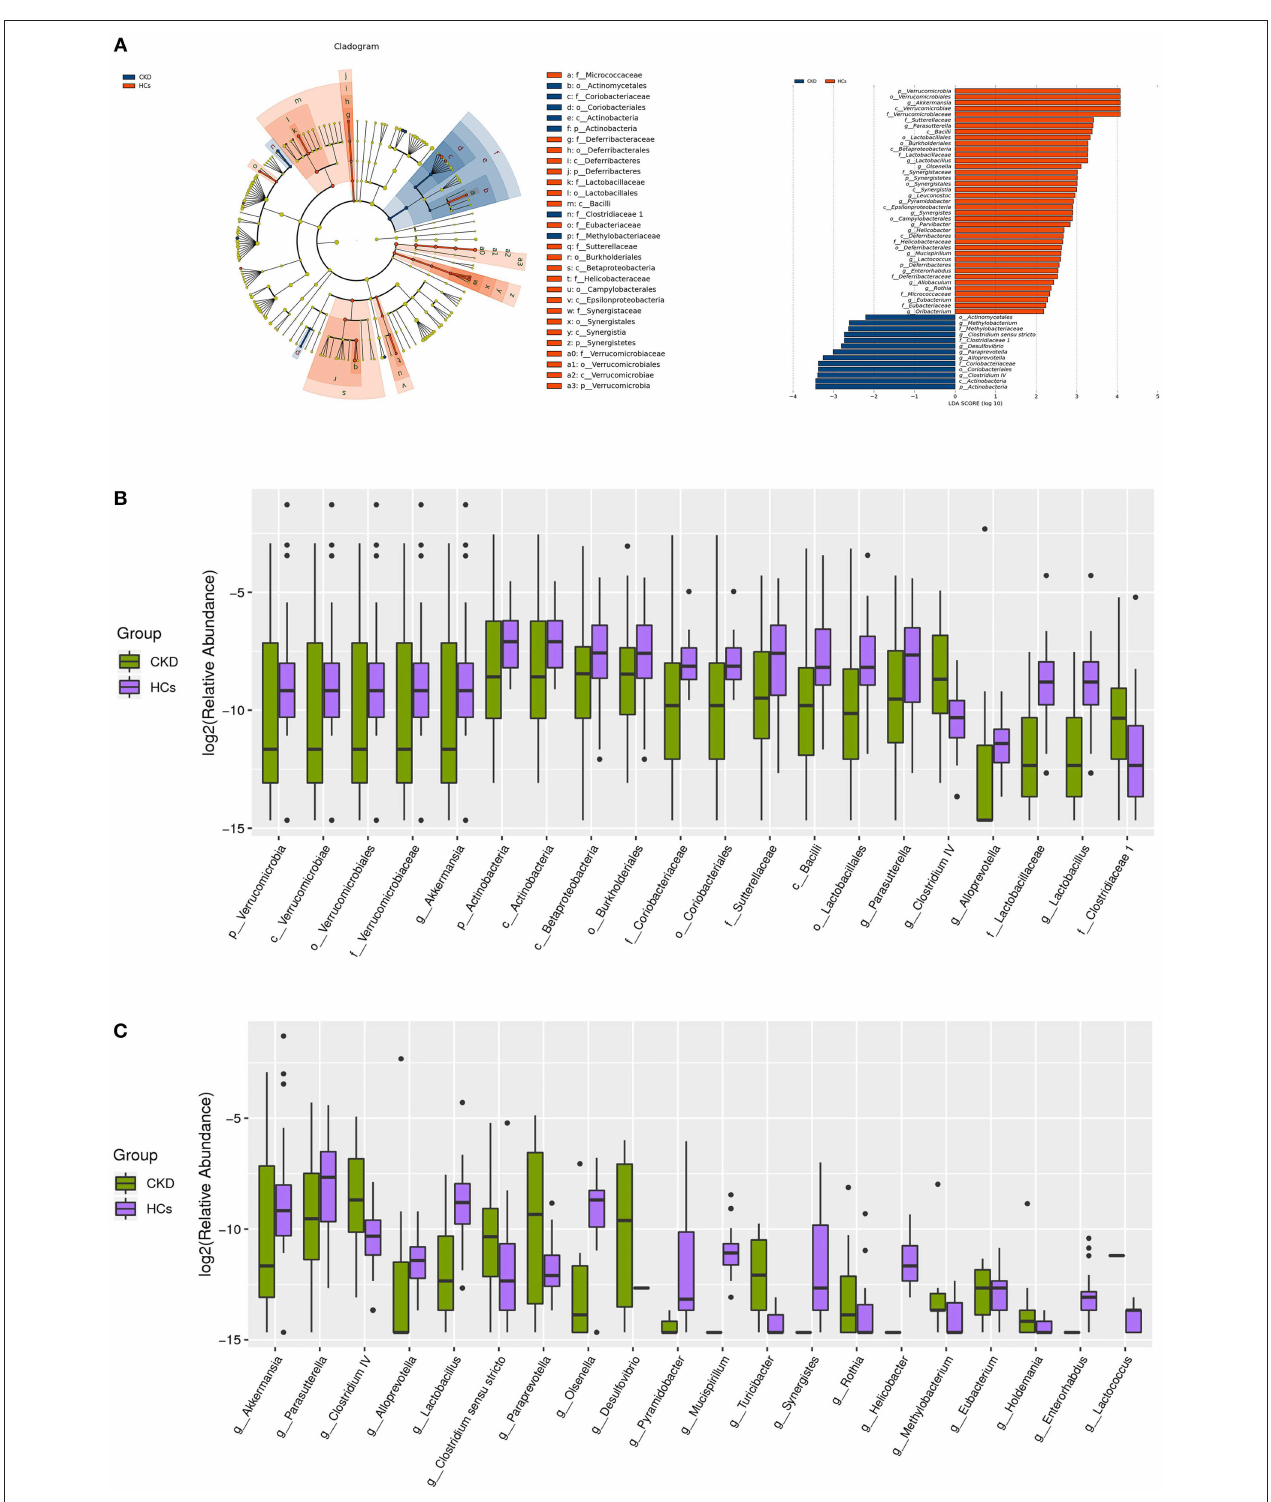
FIGURE 2 | Taxonomic differences in the fecal microbiota exhibited by patients with chronic kidney disease (CKD) and healthy control (HC) subjects. (A) A Linear discriminant analysis (LDA; (log10) > 2) and effect size (LEfSe) analysis revealed significant differences ( P < 0.05) in the fecal microbiota exhibited by the CKD (blue, negative score) and HC (red, positive score) groups. These analyses revealed the most differentially abundant taxa at the level of bacterial (B) phylum (p), class (c), order (o), family (f), and (C) genus (g) between the CKD (green) and HC (purple) groups.